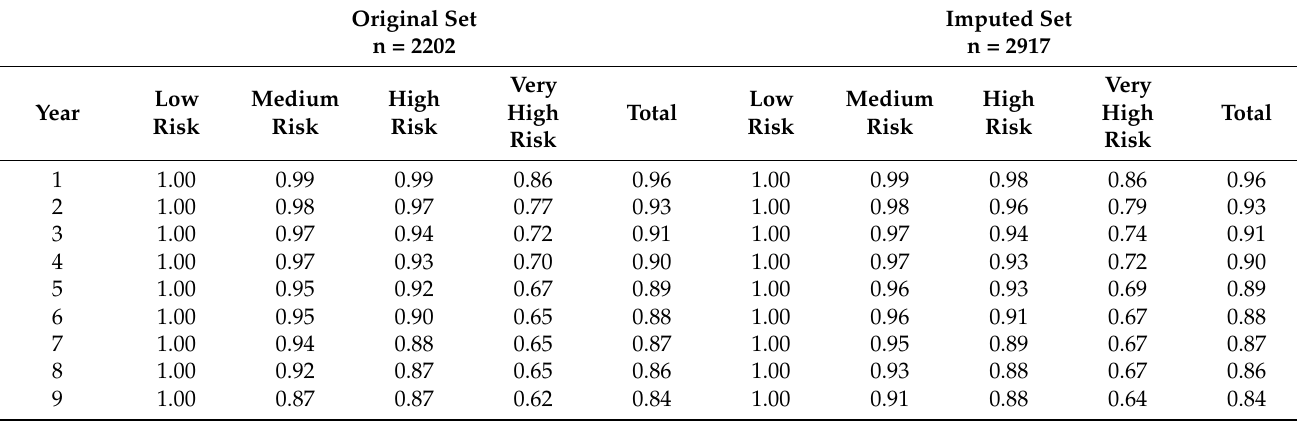
Table 3. Cause-specific survival function by years of follow-up and risk through actuarial method, before and after multiple imputation (m =